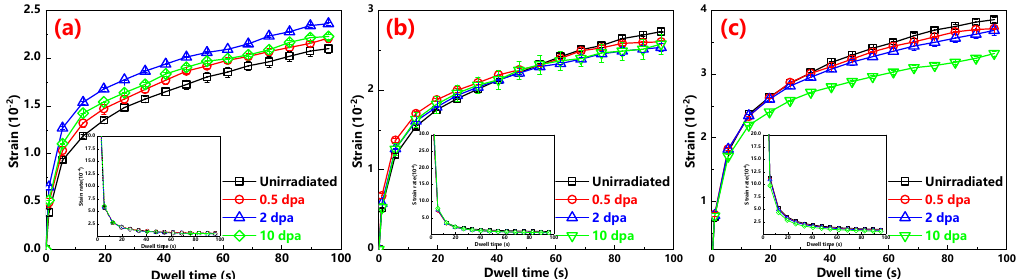
Figure 5. Strain and corresponding strain rate versus dwell time of the ( a ) Hastelloy N alloy; ( b ) Alloy 800H; ( c ) 316H stainless steel before and after ion irradiation.